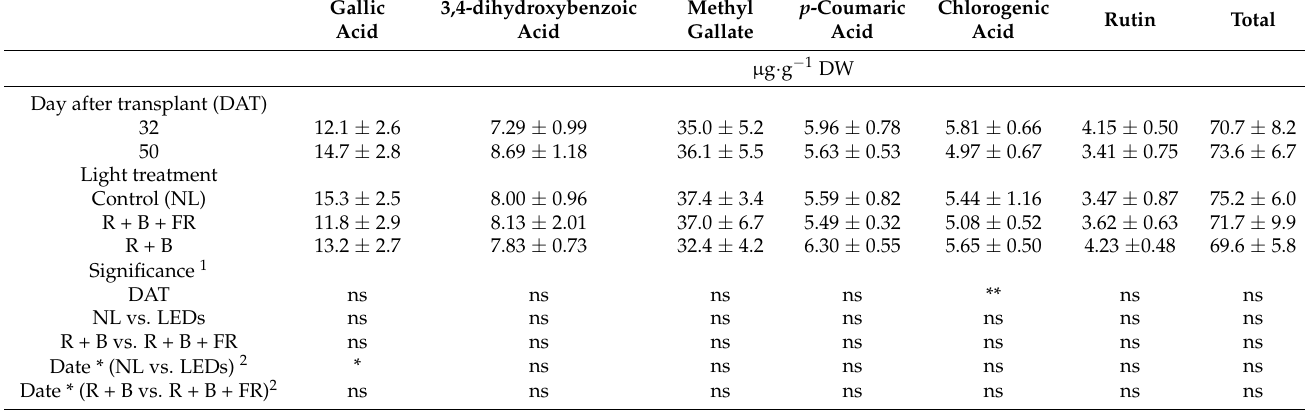
fruits was not affected by either DAT or SL, and the experimental conditions resulted in an average of 72.15 ± 2.0 µ g · g − 1 DW (Table 1). Table 1. Effects of the day of harvest and light treatments on the polyphenols profile of the fruits of a landrace of Cucumis melo L. (“Carosello leccese”). Values are the average ± DS of three replications.